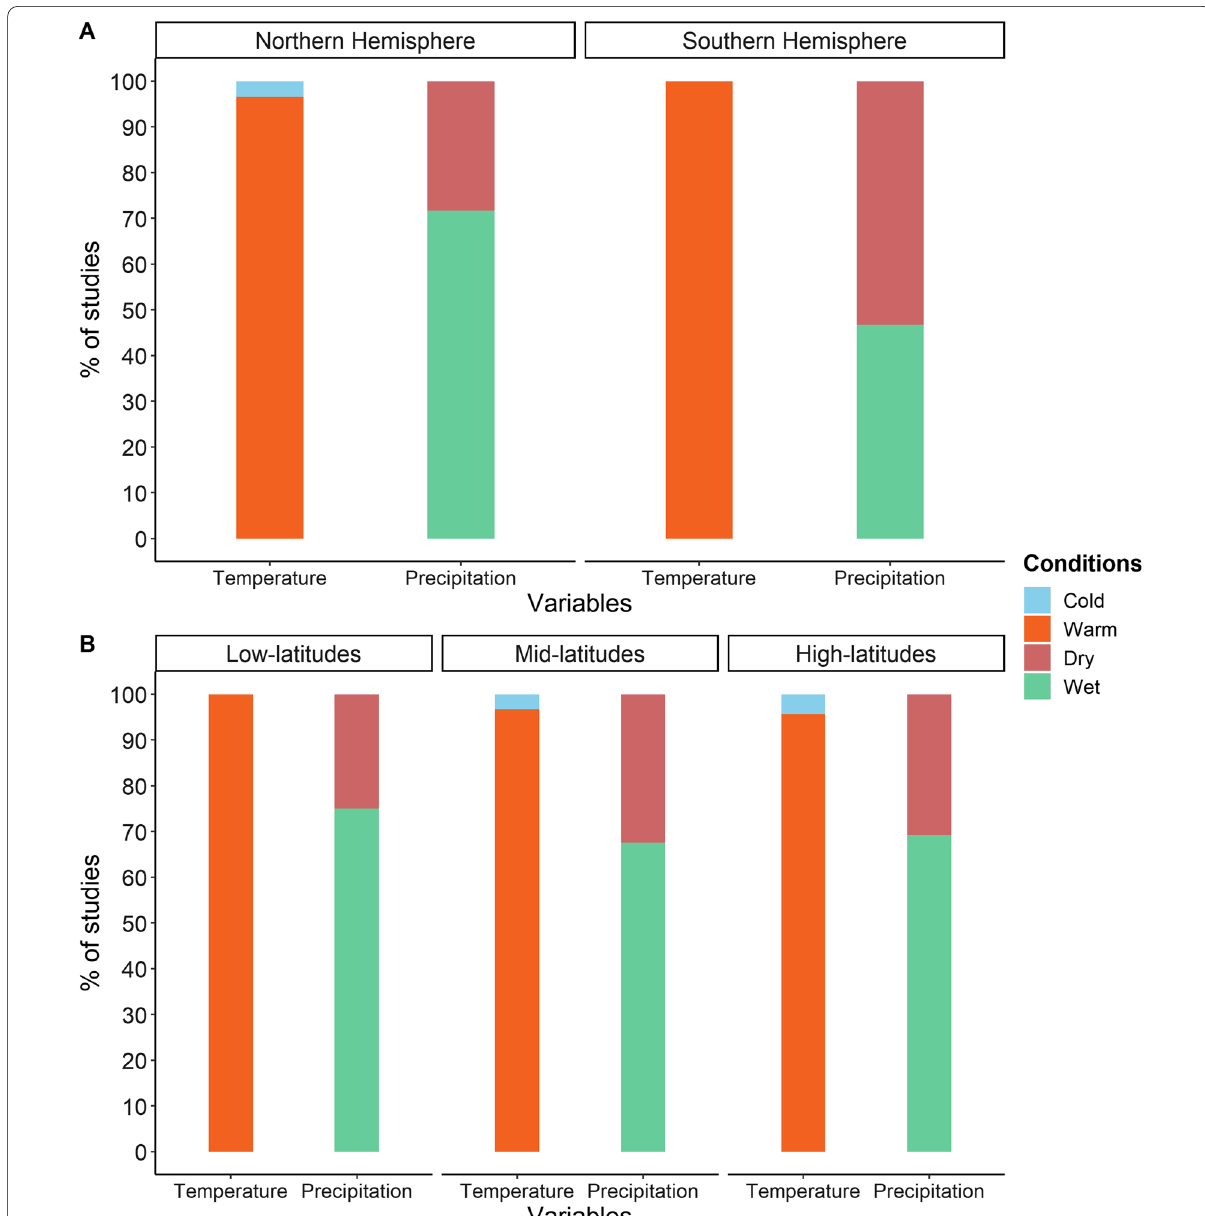
Fig. 12 Relationship of temperature and precipitation during the warm periods (MMCO, MIS5e, DO events, Bølling–Allerød interstadial, and MCA). A studies over different regions, B studies over the different